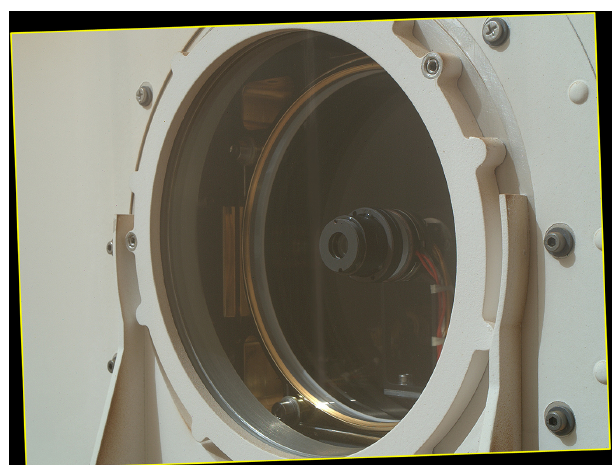
Figure 11. Example MAHLI image of the ChemCam Remote Warm Electronics Box (RWEB) window, acquired with solar illu- mination from the upper left on sol 808 (14 November 2014). This is onboard focus merge product 0808MH0001930000300748R00. MAHLI periodically images the ChemCam RWEB window, which contains the instrument’s laser, telescopic optics and remote micro- scopic imager (RMI) (Maurice et al., 2012), to detect changes in dust contamination. MAHLI is also sometimes used to image the fiber optic cable that carries ChemCam signals to the spectrometers within the rover body (Wiens et al., 2012), to look for cable